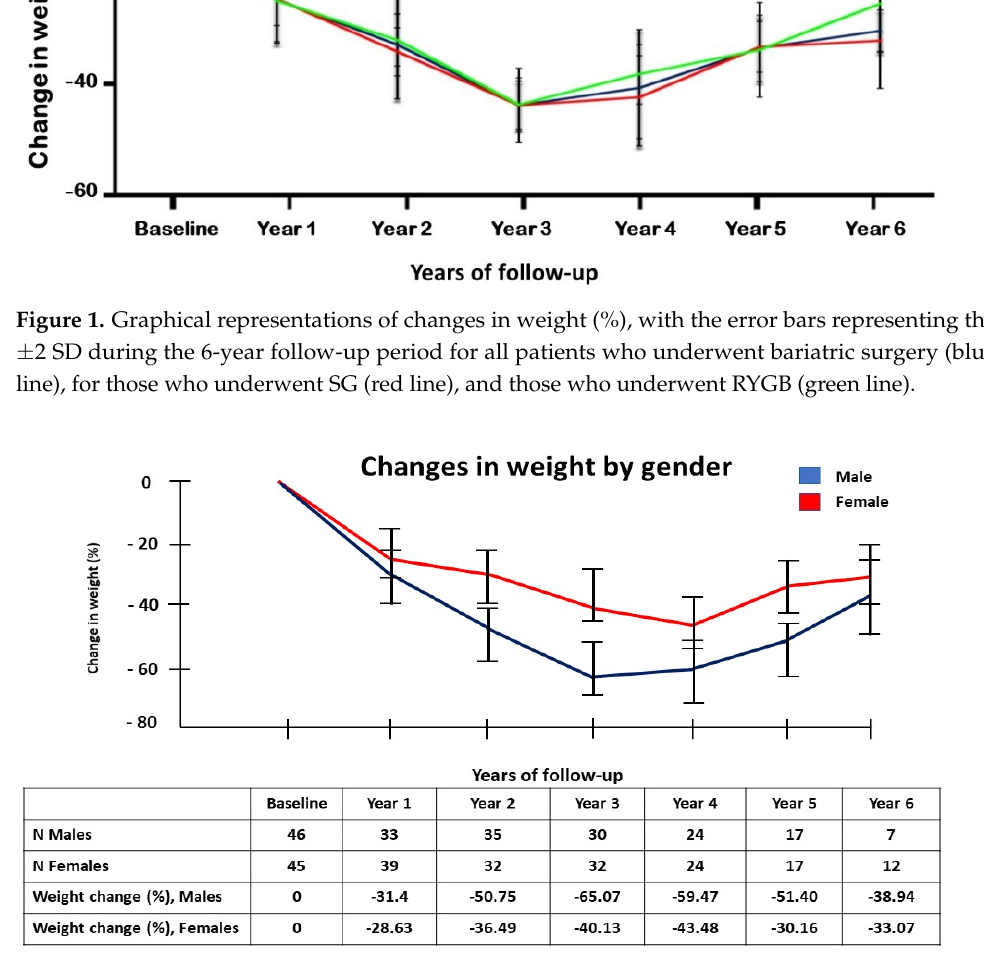
Figure 2. Graphical representation of weight change (%), with the error bars representing the ± 2 SD, according to gender of the patients post bariatric surgery during the 6-year follow-up period. The number of patients at each time point and the mean percentage weight loss in male and female participants is shown. SD-standard deviation.